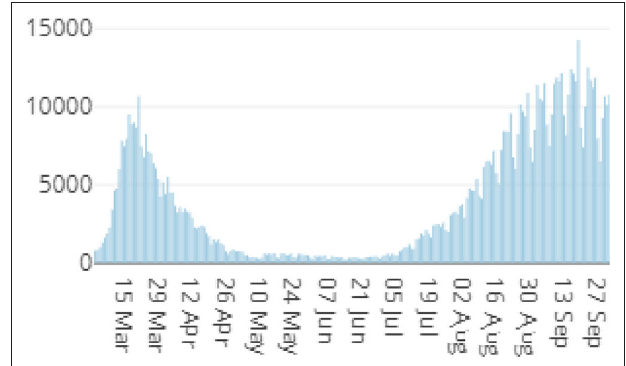
FIGURE 1 | Number of cases reported between the first wave and the second wave in Spain [adapted from the Ministerio de Sanidad (2021); see https://